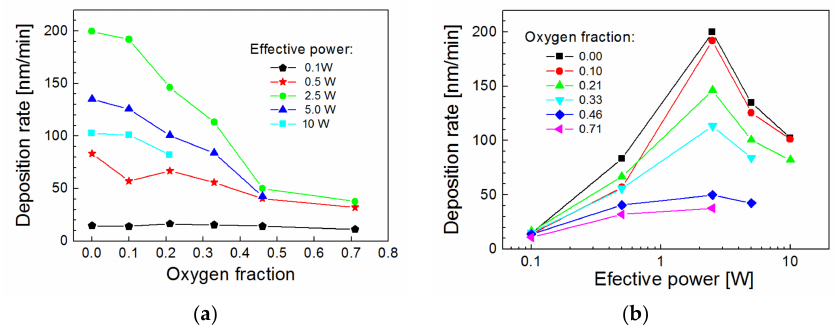
Figure 3. Deposition rate as a function of ( a ) oxygen fraction for different effective power and ( b ) effective power for different oxygen fractions.